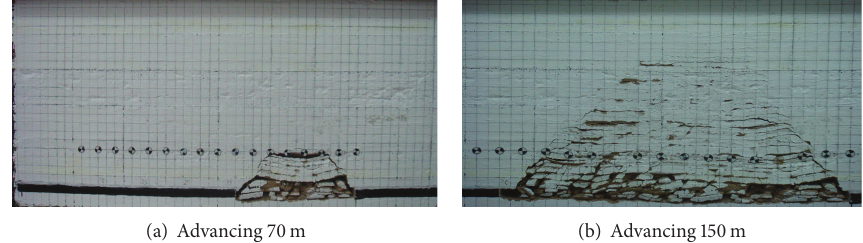
Figure 4: Overlying movement characteristics.